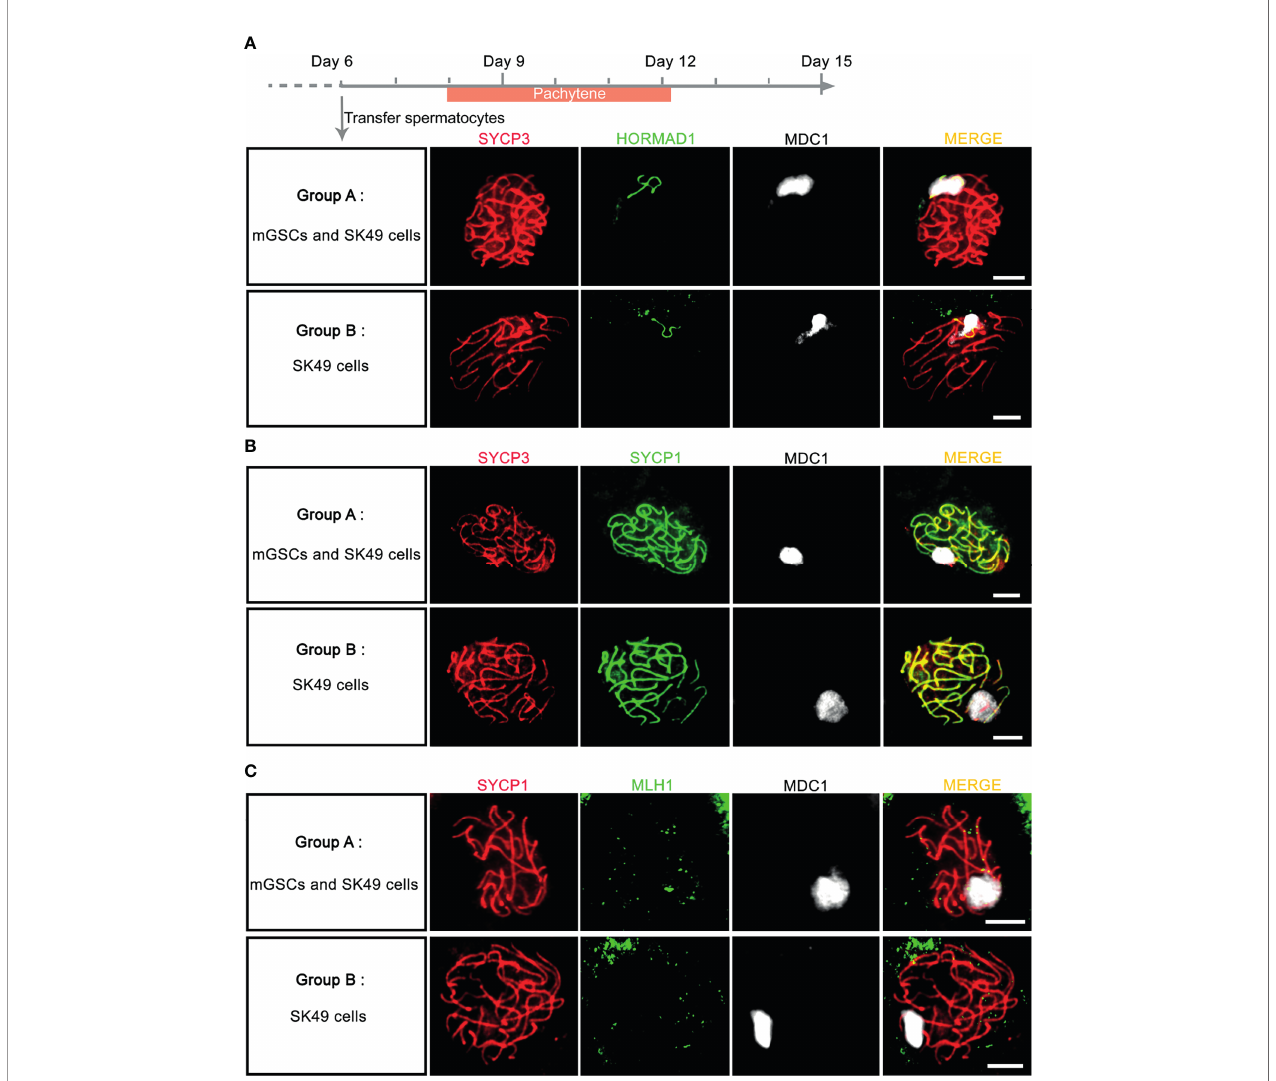
FIGURE 5 | Chromosome synapsis was completed without the addition of fresh mGSCs. (A, B) In vitro - generated pachytene spermatocytes stained for SYCP3 (red), MDC1 (white), (A) HORMAD1 (green) or (B) SYCP1 (green) were observed both group A (undifferentiated mGSCs on a fresh layer of proliferatively inactivated SK49 Sertoli cells) and group B (a fresh layer of proliferatively inactivated SK49 Sertoli cells alone) from day 8 to day 12. (C) In vitro - generated pachytene spermatocytes stained for SYCP1 (red), MLH1 (green) and MDC1 (white) in group (A, B) . Scale bars, 5 m